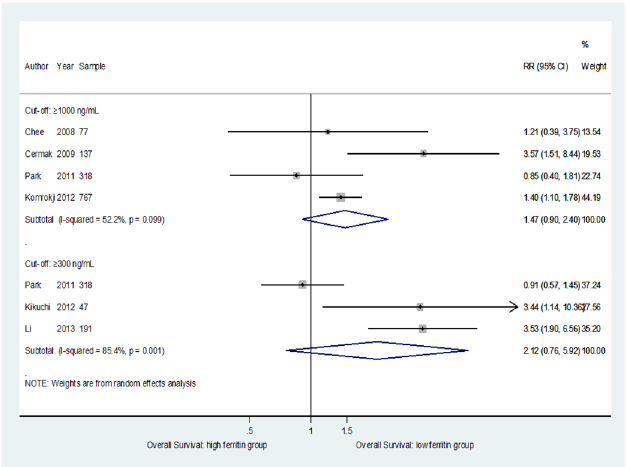
Fig 2. Forest plot of the association of OS and SF according to SF (cid:21) 1000ng/ml and SF (cid:21) 300 ng/ml cut- offs.